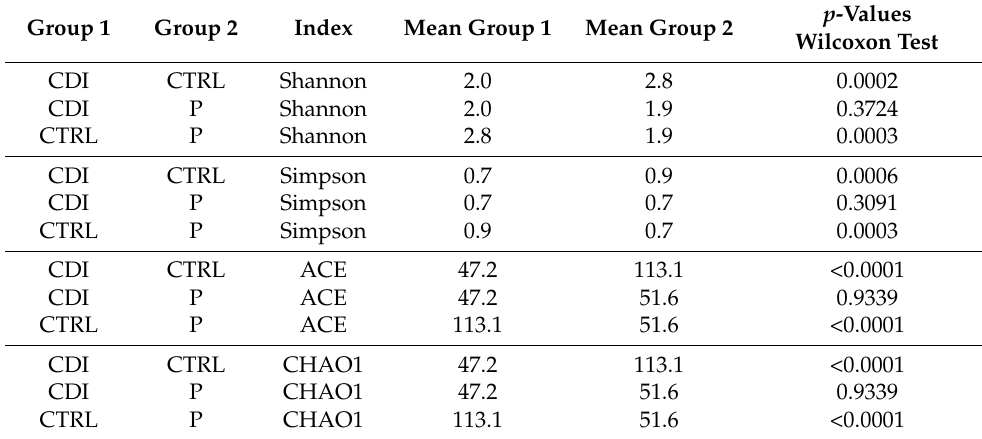
Table 2. Comparison of alpha diversity indices and richness estimators in study